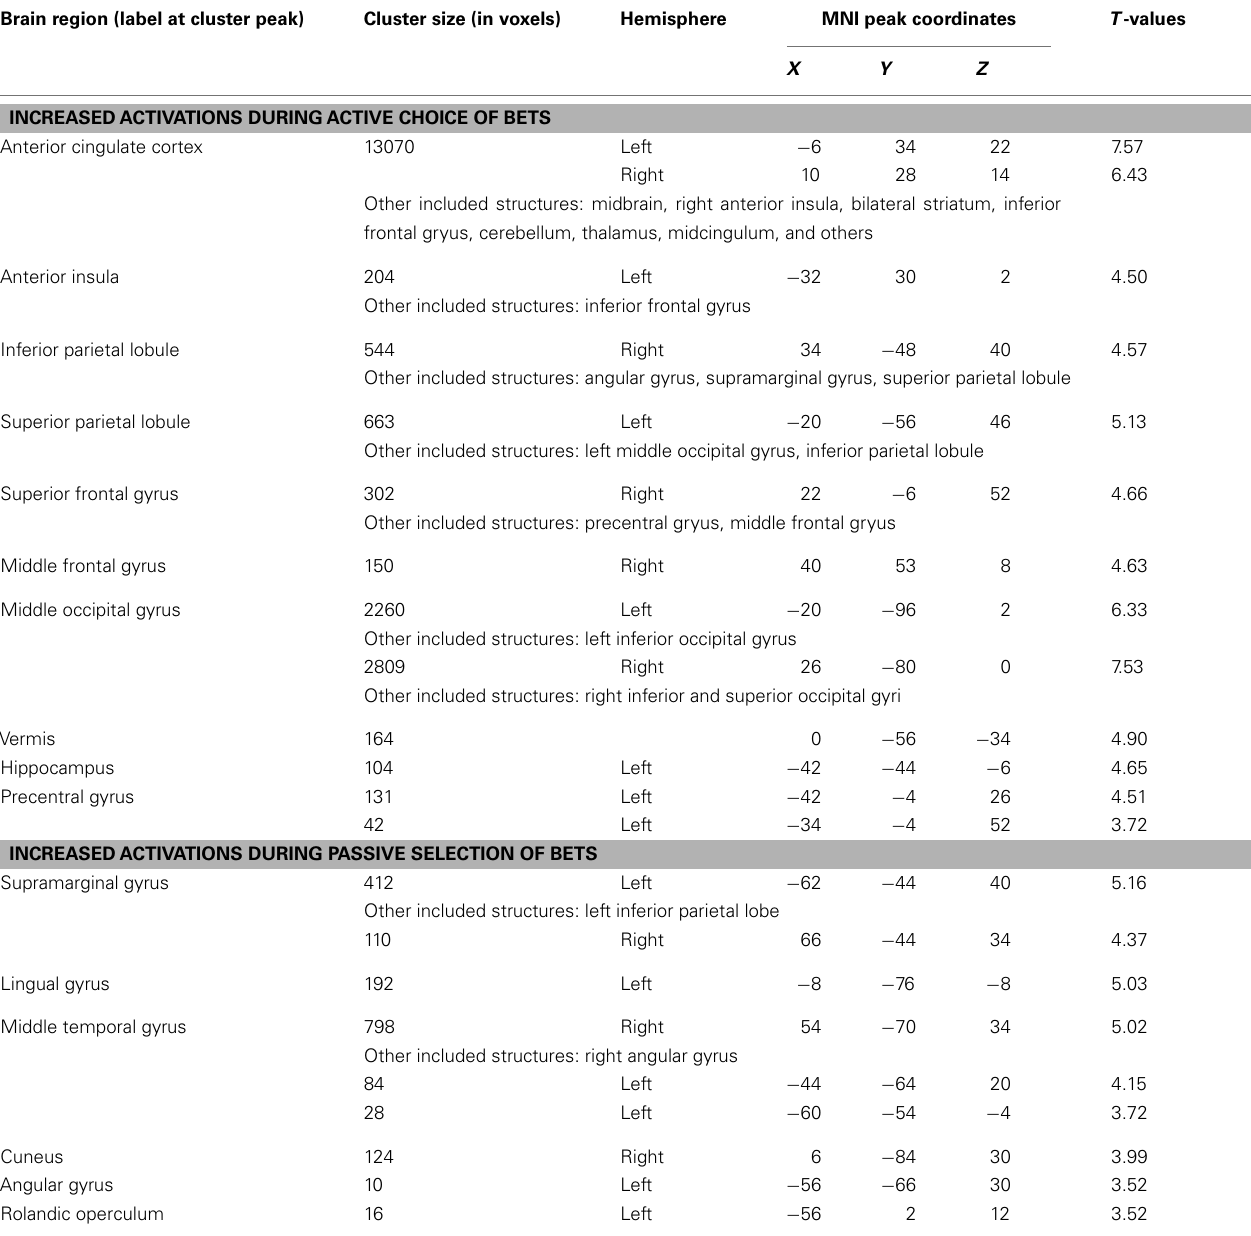
TableA1 | Neural correlates of active compared to passive selection of bets identified in the exploratory whole-brain analysis ( P < 0.001, k = 10). Brain region (label at cluster